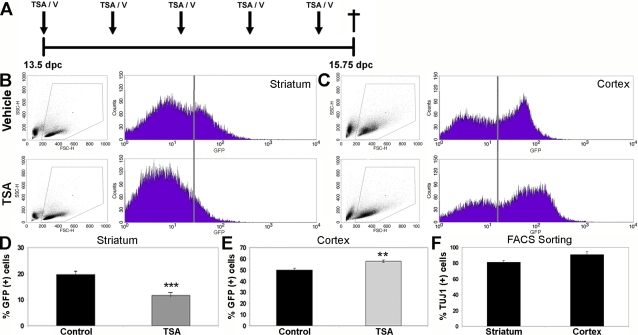
HDAC inhibition by TSA in utero restricts GE-derived neurogenesis and promotes cortical neurogenesis.(A) Timed-pregnant female tauGFP mice were injected every 12 hours with vehicle (B, C, upper diagrams) or with 12.5 µg TSA (B, C, lower diagrams), starting from 13.5 d.p.c., and embryos were examined 54 hours later at 15.75 d.p.c. FACS analysis was performed upon dissociated GE-derived (B) and cortical (C) cells, using GFP as a marker for newborn neurons. For each treatment and tissue (B, C), a scatter plot showing forward (FSC-H) versus side scatter (SSC-H) is shown on the left, and a histogram displaying GFP intensity versus the number of events is shown on the right. The population of cells analysed for green fluorescence is indicated by the gate in the scatter plots (left panel). All cells to the right of the vertical line in the histogram (right panel) were judged to be GFP-positive and therefore neurons. (D, E) Quantitation of the GFP-positive neuronal population in the developing GE (D) and cortex (E), treated with vehicle (Control) or with TSA (TSA). Mean values +/− SEM (n>6). ** = p<0.01, *** = p<0.001, Mann-Whitney U test. (F) GFP-positive cells were collected from embryonic cortex and GE by FACS sorting, plated out, and cultured for 3 hours, and then stained for expression of β-tubulin III to verify their neuronal identity (n = 2).